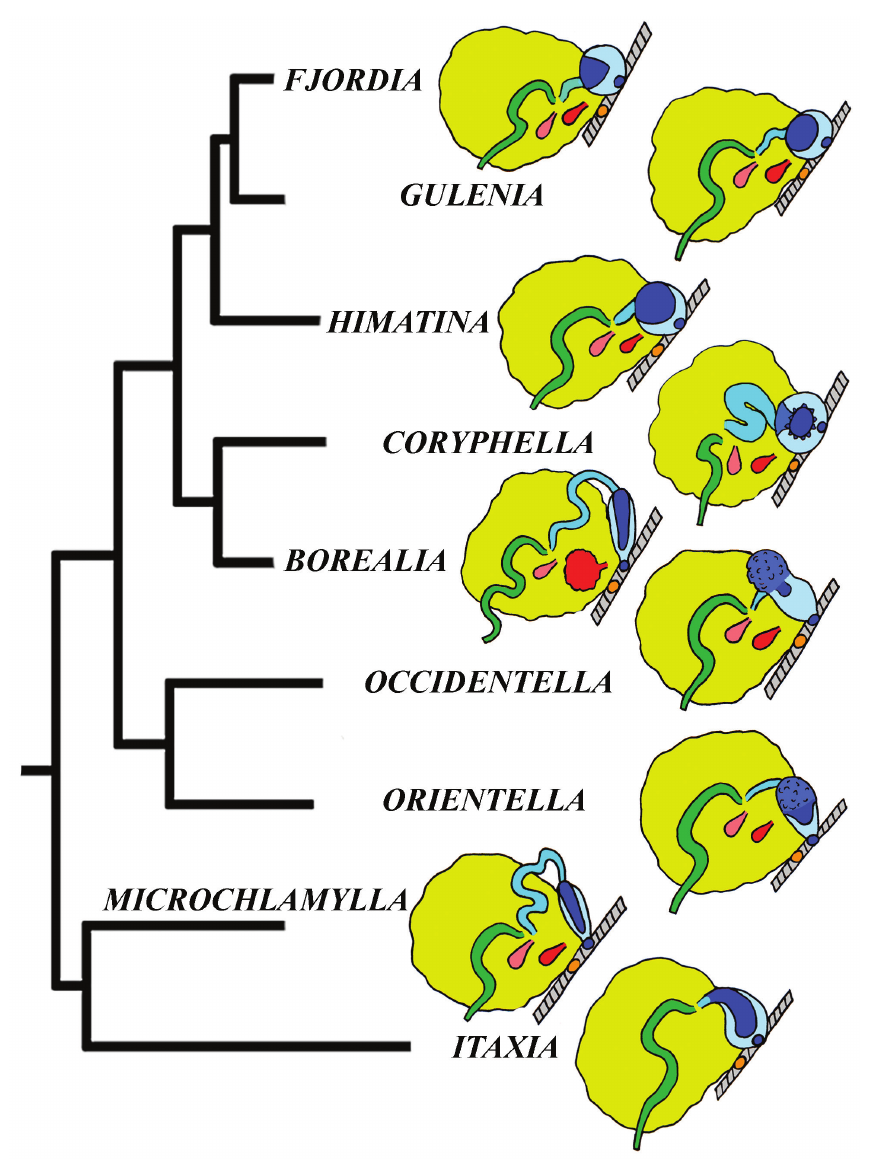
Figure 21. Schematic outline of the reproductive systems of the taxa of the families Coryphellidae in- tegrated with molecular phylogenetic data. Colour indication of reproductive system characters: ampulla – green; body wall – gray; distal receptaculum seminis – red; female gland mass – yellow; female genital opening – orange; penis and male genital opening – dark blue; penial sheath – pale blue; prostatic vas deferens – turquoise; proximal distal receptaculum seminis –